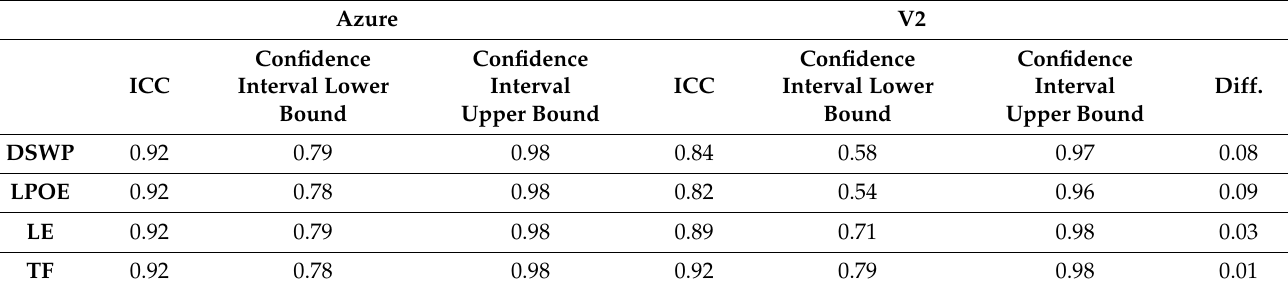
Table 5. Intra-rater reliability ICC 3,1 within Azure and V2.